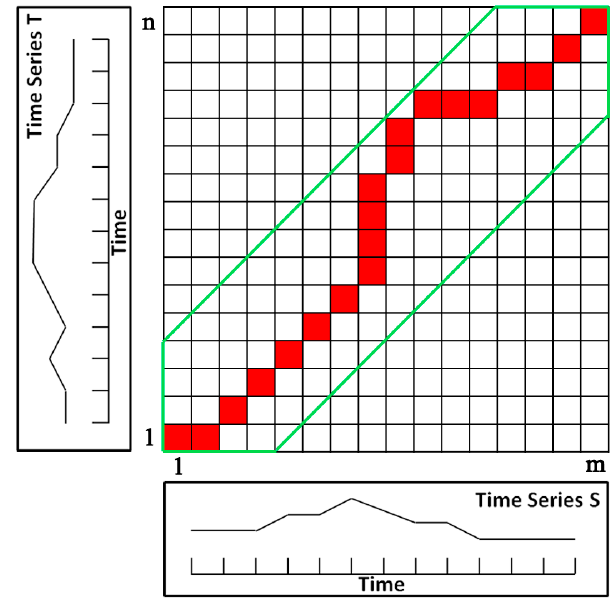
Figure 5. The optimal warping path between time series T and S (red squares).